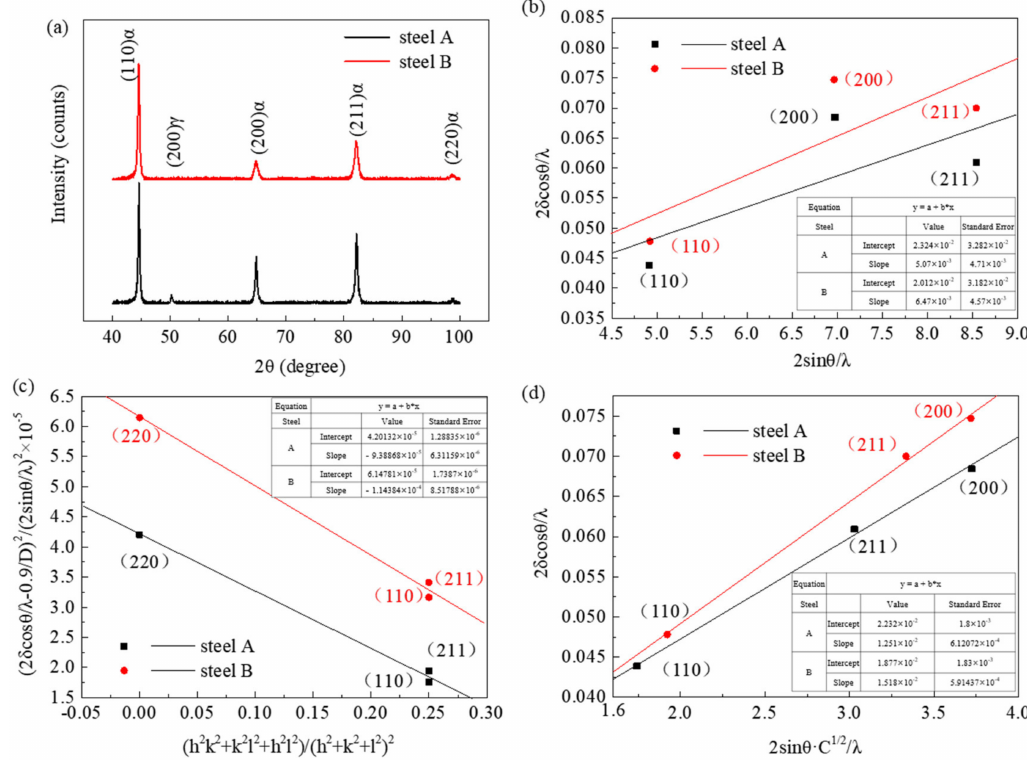
Figure 17. ( a ) The measured XRD profiles, the estimation of dislocation density for steel A and B under flash heating to 880 ◦ C then air cooling according to a linear relationship between 2sin θ / λ and 2 δ cos θ / λ ( b ), (h 2 k 2 +k 2 l 2 +h 2 l 2 )/(h 2 +k 2 +l 2 ) 2 and (2 δ cos θ / λ –0.9/ D ) 2 /(2sin θ / λ ) 2 ( c ), 2sin θ · C 1/2 / λ and 2 δ cos θ / λ ( d